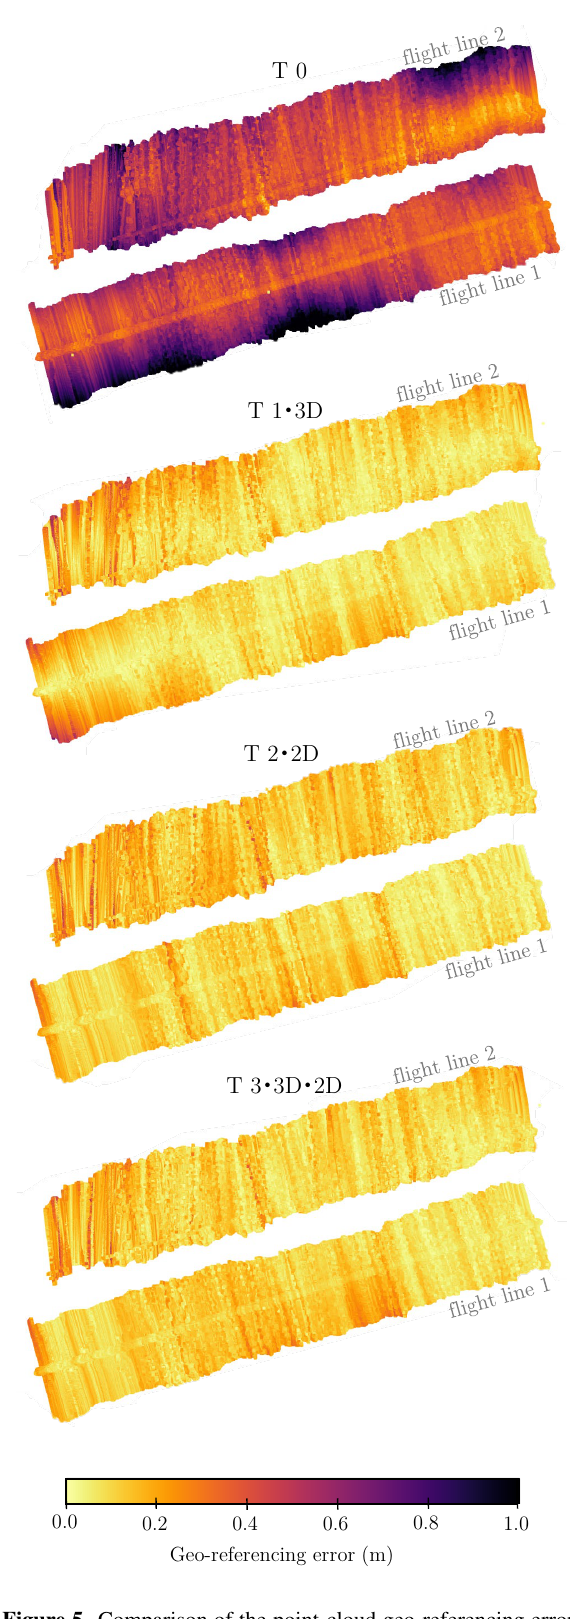
Figure 5. Comparison of the point-cloud geo-referencing errors generated from each